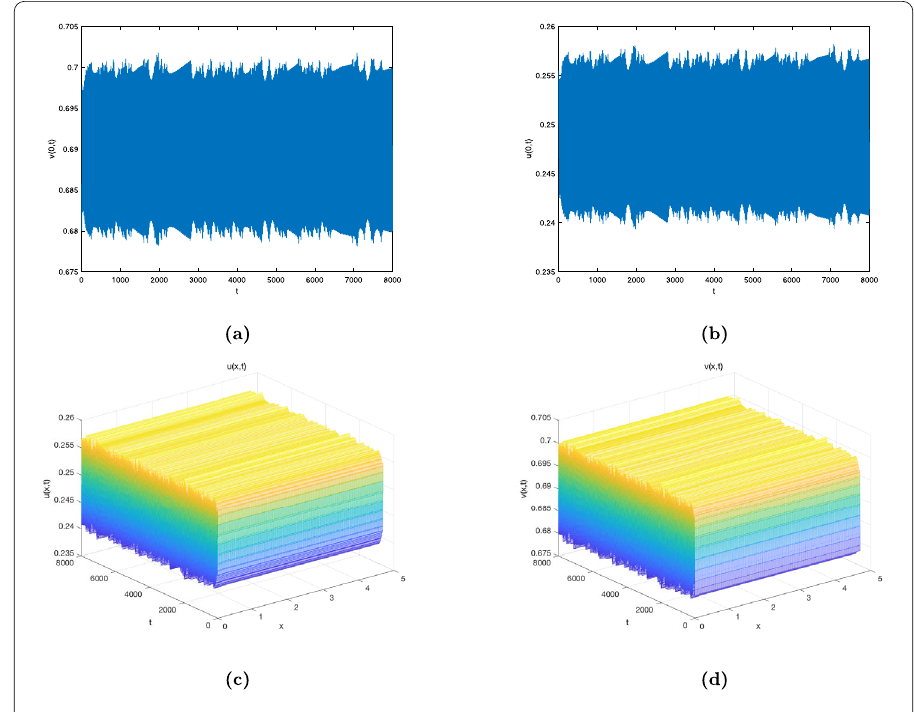
Figure 3 When the initial values u ( x ,0) = 0.25, v ( x ,0) = 0.68, spatial quasi-periodic solutions